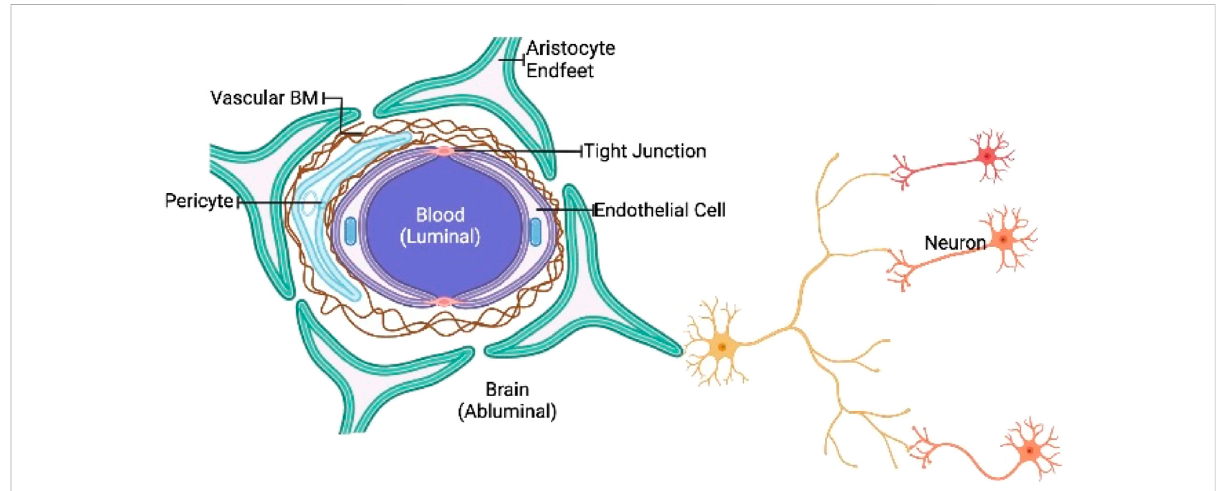
FIGURE 1 Schematic representation of BBB. The BBB is a highly biased semipermeable barrier of endothelial cells that blocks the non-selective movement of substances in the bloodstream into the extracellular fl uid of the central nervous system, where neurons